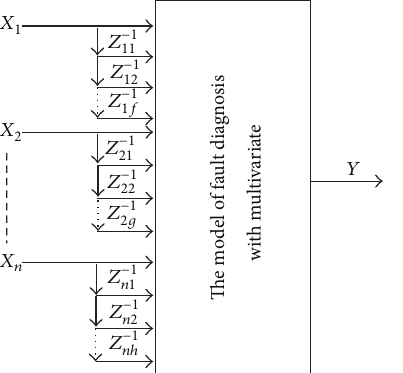
Figure 1: The fault diagnosis with multivariate.